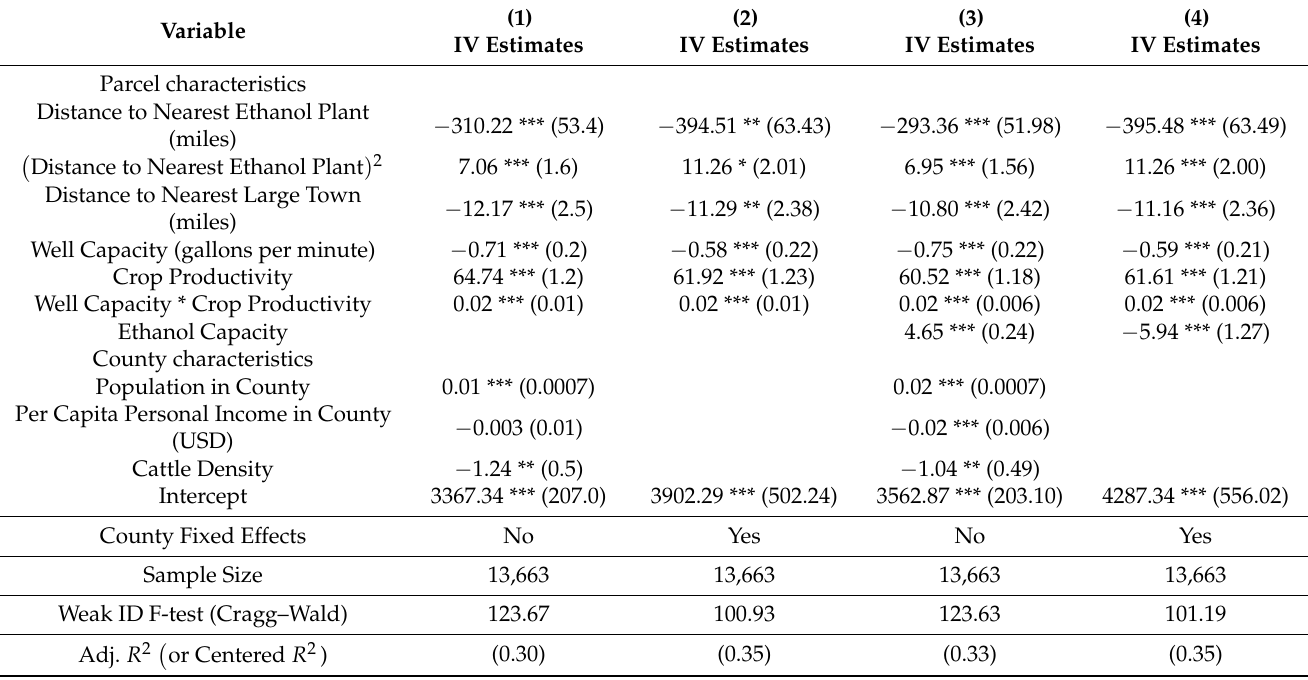
Table 4. Robustness check: IV estimates of the effect of proximity to ethanol plants on farmland values